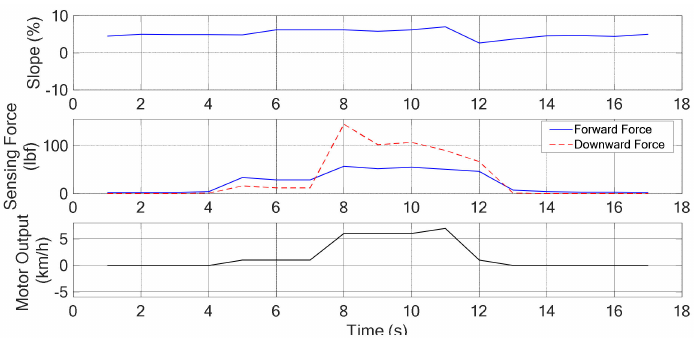
Figure 16. The degree of slope, sensing force, and the assistive motor output (steeper